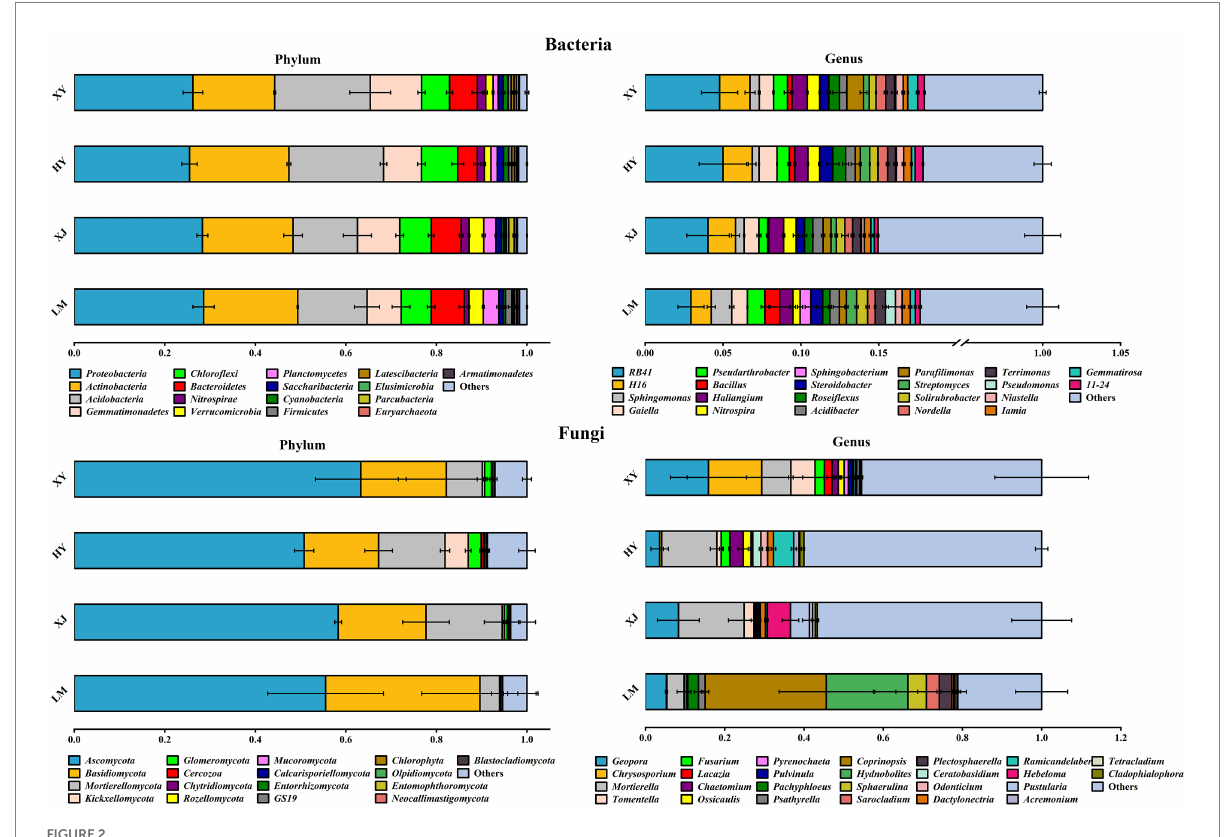
FIGURE 2 Rhizosphere microbial community compositions of four Populus